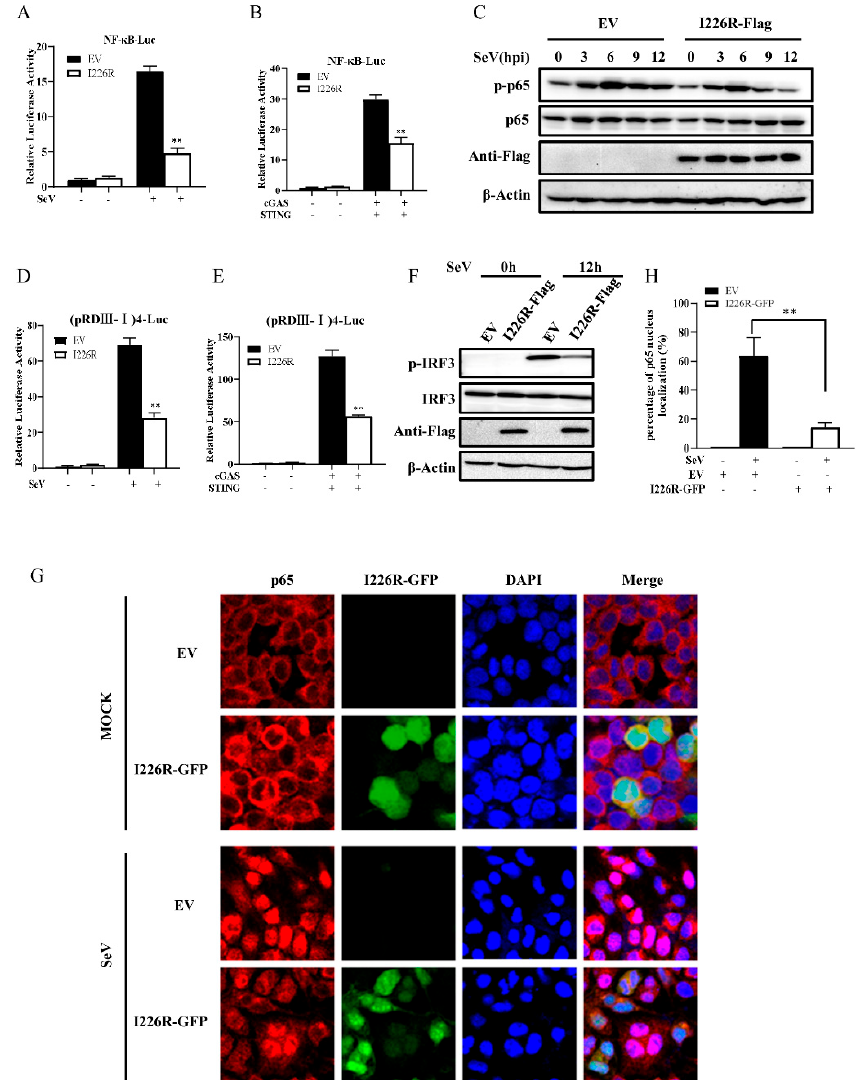
Figure 5. The I226R protein impairs the activation of NF- κ B and IRF3 signaling: ( A ) 500 ng NF- κ B- Luc, 50 ng pRL-TK, and 500 ng I226R-Flag or EV were co-transfected with 293T cells for 24 h and infected with SeV for 16 h. The NF- κ B luciferase activity was measured. ( B ) 300 ng NF- κ B-Luc, 30 ng pRL-TK, and 300 ng I226R-Flag or EV were co-transfected in 293T cells for 24 h with 300 ng cGAS-Flag and 50 ng STING-HA. The NF- κ B luciferase activity was measured. ( C ) 293T cells were transfected 3 µ g I226R-Flag or EV for 24 h and infected with SeV for indicated time. Western blotting was performed to detect the phosphorylation levels of p65. ( D ) 500 ng (pRDIII-I)4-Luc was used instead of NF- κ B-Luc, as described in panel A. The IRF3 luciferase activity was measured. ( E ) 300 ng (pRDIII-I)4-Luc was used instead of 300 ng NF- κ B-Luc, as described in panel B. The IRF3 luciferase activity was measured. ( F ) 293T cells were transfected with 3 µ g I226R-Flag or EV and infected with SeV for 12 h. Western blotting was then performed to detect the phosphorylation levels of IRF3. ( G , H ) 293T cells were transfected with 3 µ g I226R-GFP or EV and infected with SeV for 12 h. The cells were stained with anti-p65 Ab. Alex Fluor 594-conjugated IgG (red) was used as the secondary antibody. Cell nuclei were stained with DAPI (blue). The images were obtained by laser scanning confocal microscope using a 20 × objective ( G ). Quantification of the nuclear translocation of p65 was determined by counting 100 cells from at least three independent fields ( H ). Shown are percentages of cells with p65 located in the nuclei. The results are expressed as the means ± standard deviation from three independent experiments. Statistical analysis was performed using the Student’s t -test. ** p <